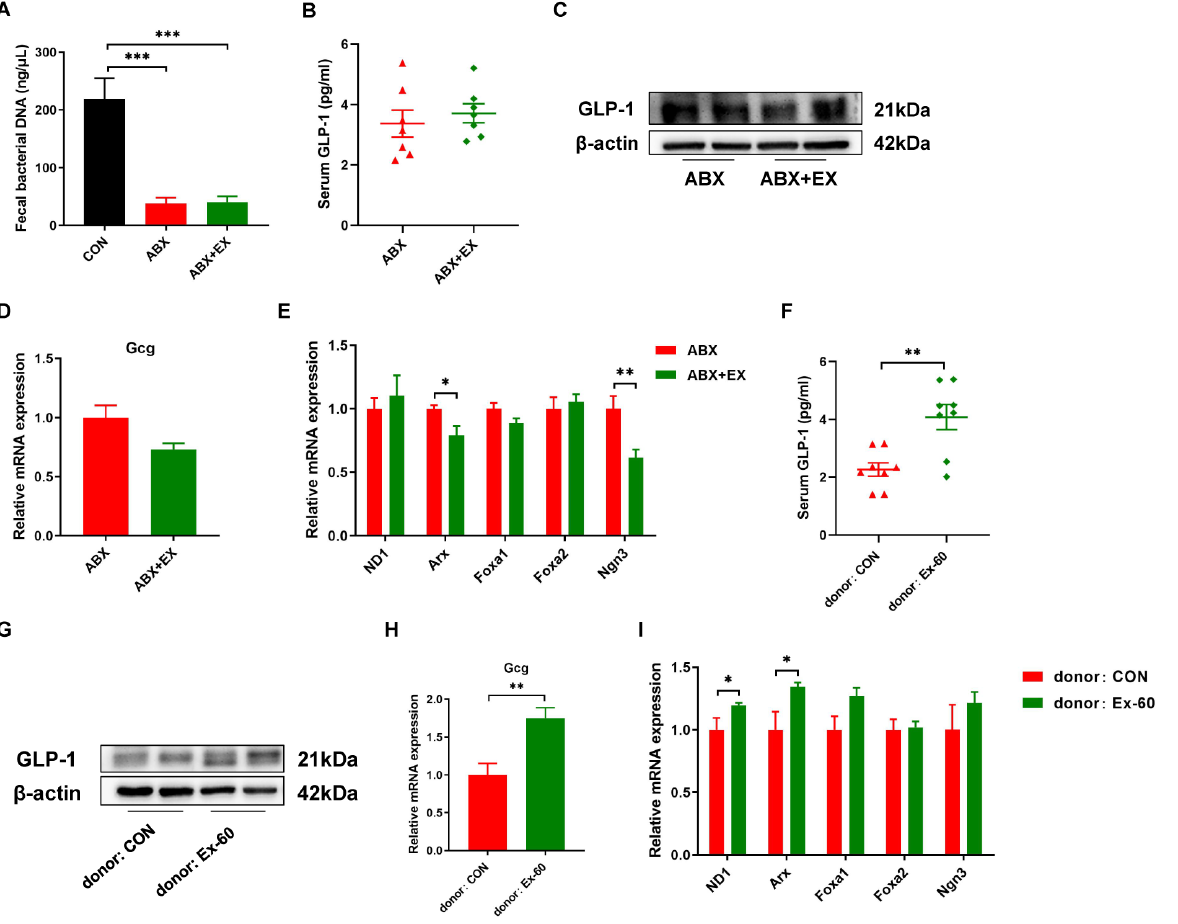
Figure 5. The gut microbiota contributes to the effects of exercise-induced GLP-1 secretion. ( A ) The concentration of fecal bacterial DNA. ( B , F ) GLP ‐ 1 levels were measured using an ELISA kit in serum. ( C , G ) Representative western blot of GLP ‐ 1 from colon samples. ( D , H ) qPCR analysis of the expression of the Gcg gene in the colon. ( E , I ) qPCR analysis of the expression of the regulators of L cell proliferation in the colon. Data are expressed as the mean ± SEM. One ‐ way ANOVA: ( A ). Unpaired t ‐ test: ( B , D – F , H , I ). * p < 0.05, ** p < 0.01, and *** p < .001.